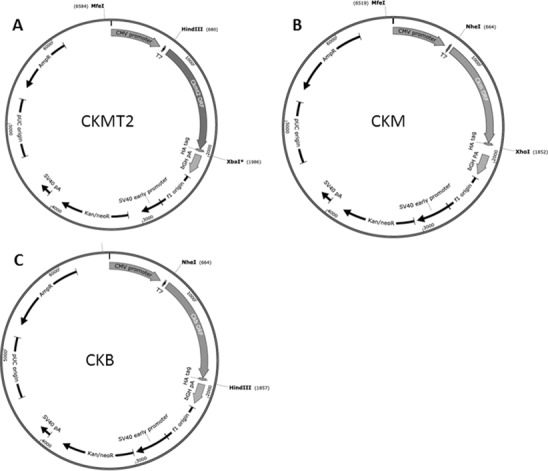
Cloning of human CK isoenzyme ORF sequences into pcDNA3.1(-).A-C: Each ORF was ligated into the multiple cloning site of the expression vector and in particular, for CKMT2 using HindIII/XbaI; for CKM, at the NheI/XhoI sites; for CKB at the NheI/HindIII sites. These restriction sites were unique in the final vector sequence. For protein detection purposes, all CK sequences were HA-tagged at the 3’ end. The three vectors were linearized at the MfeI site prior to transfection and stable selection by G418.